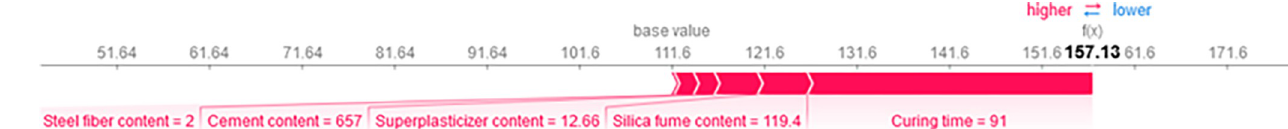
Fig 23. SHAP plot of compressive